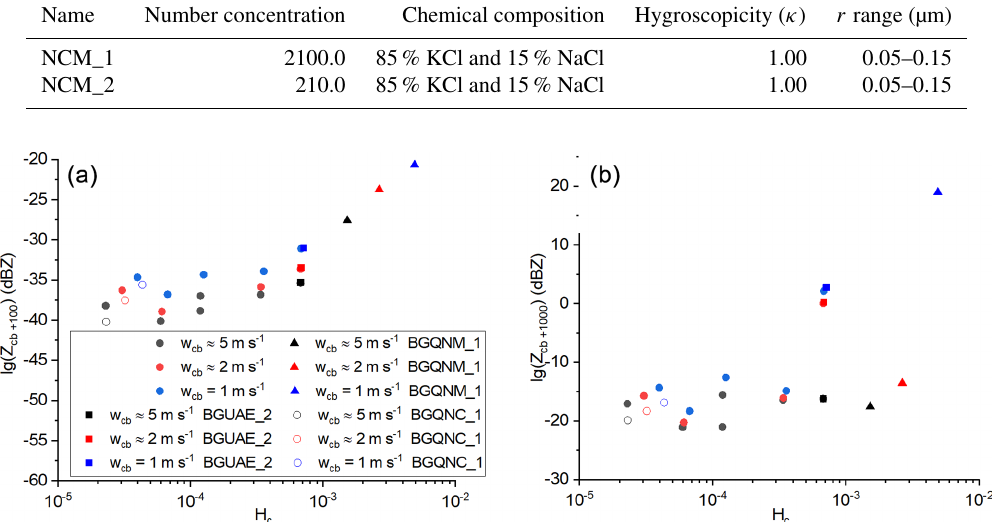
Figure 3. Reflectivity calculated from the modeled DSD (a) 100m and (b) 1000m above the cloud base for non-seeded control cases. Symbols with different colors represent different updraft velocities at the cloud base as indicated by the key. Three different background aerosol size distributions are presented by solid triangles, squares and open circles (see the legend in panel a ). The solid circles represent all six other background conditions (BGUEA_1, BGUAE_3, BGUAE_5, BGUAE_6 and BGQNC_2 with three corresponding updraft profiles except for the BGUAE_4 case where H c is